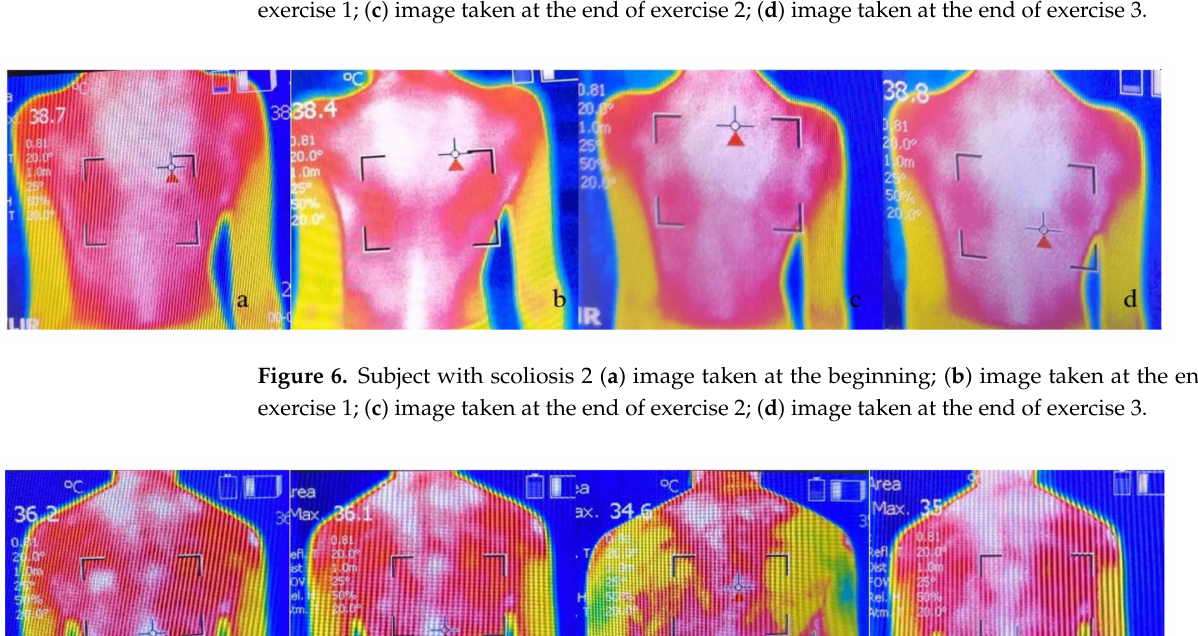
Figure 5. Subject with scoliosis 1 ( a ) image taken at the beginning; ( b ) image taken at the end of exercise 1; ( c ) image taken at the end of exercise 2; ( d ) image taken at the end of exercise 3.